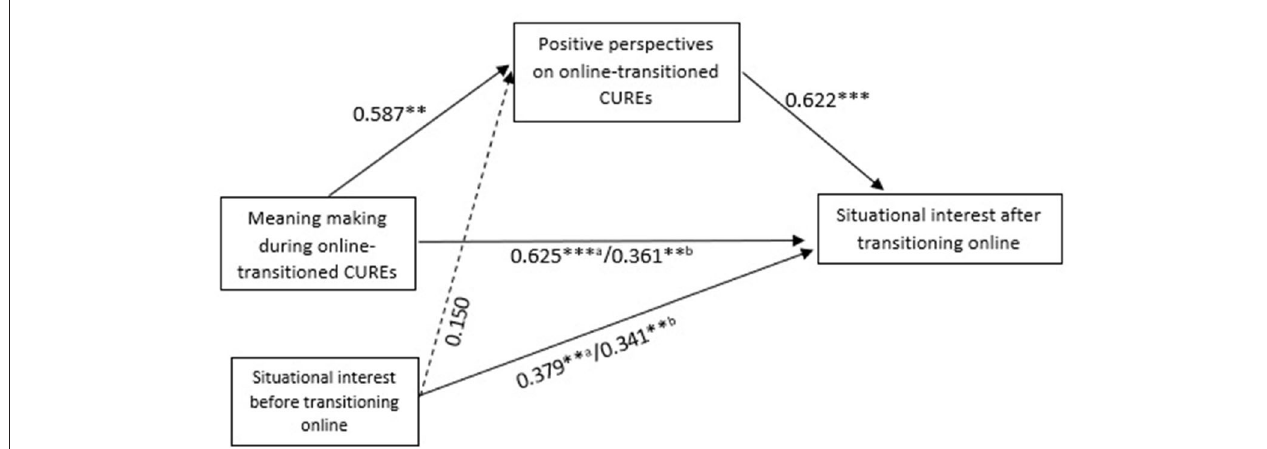
FIGURE 4 | The mediation model with standardized regression coefficients. Student meaning making during online-transitioned CUREs serves as the independent variable, positive perspectives on online-transitioned CUREs is the mediating variable, and situational interest after transitioning online is the dependent variable. “a” is the standardized β before including the mediating variable. “b” is the standardized β after including the mediating variable. All simple linear regression models include students’ situational interest before transitioning online as a controlled variable. ** p < 0.01, *** p < 0.001.